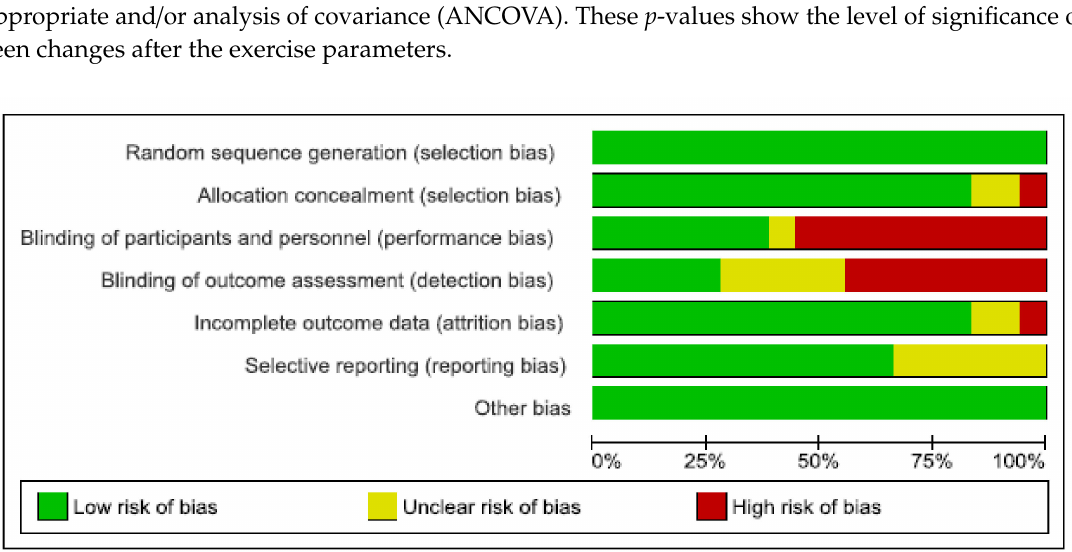
Figure 2. Risk of bias graph of included